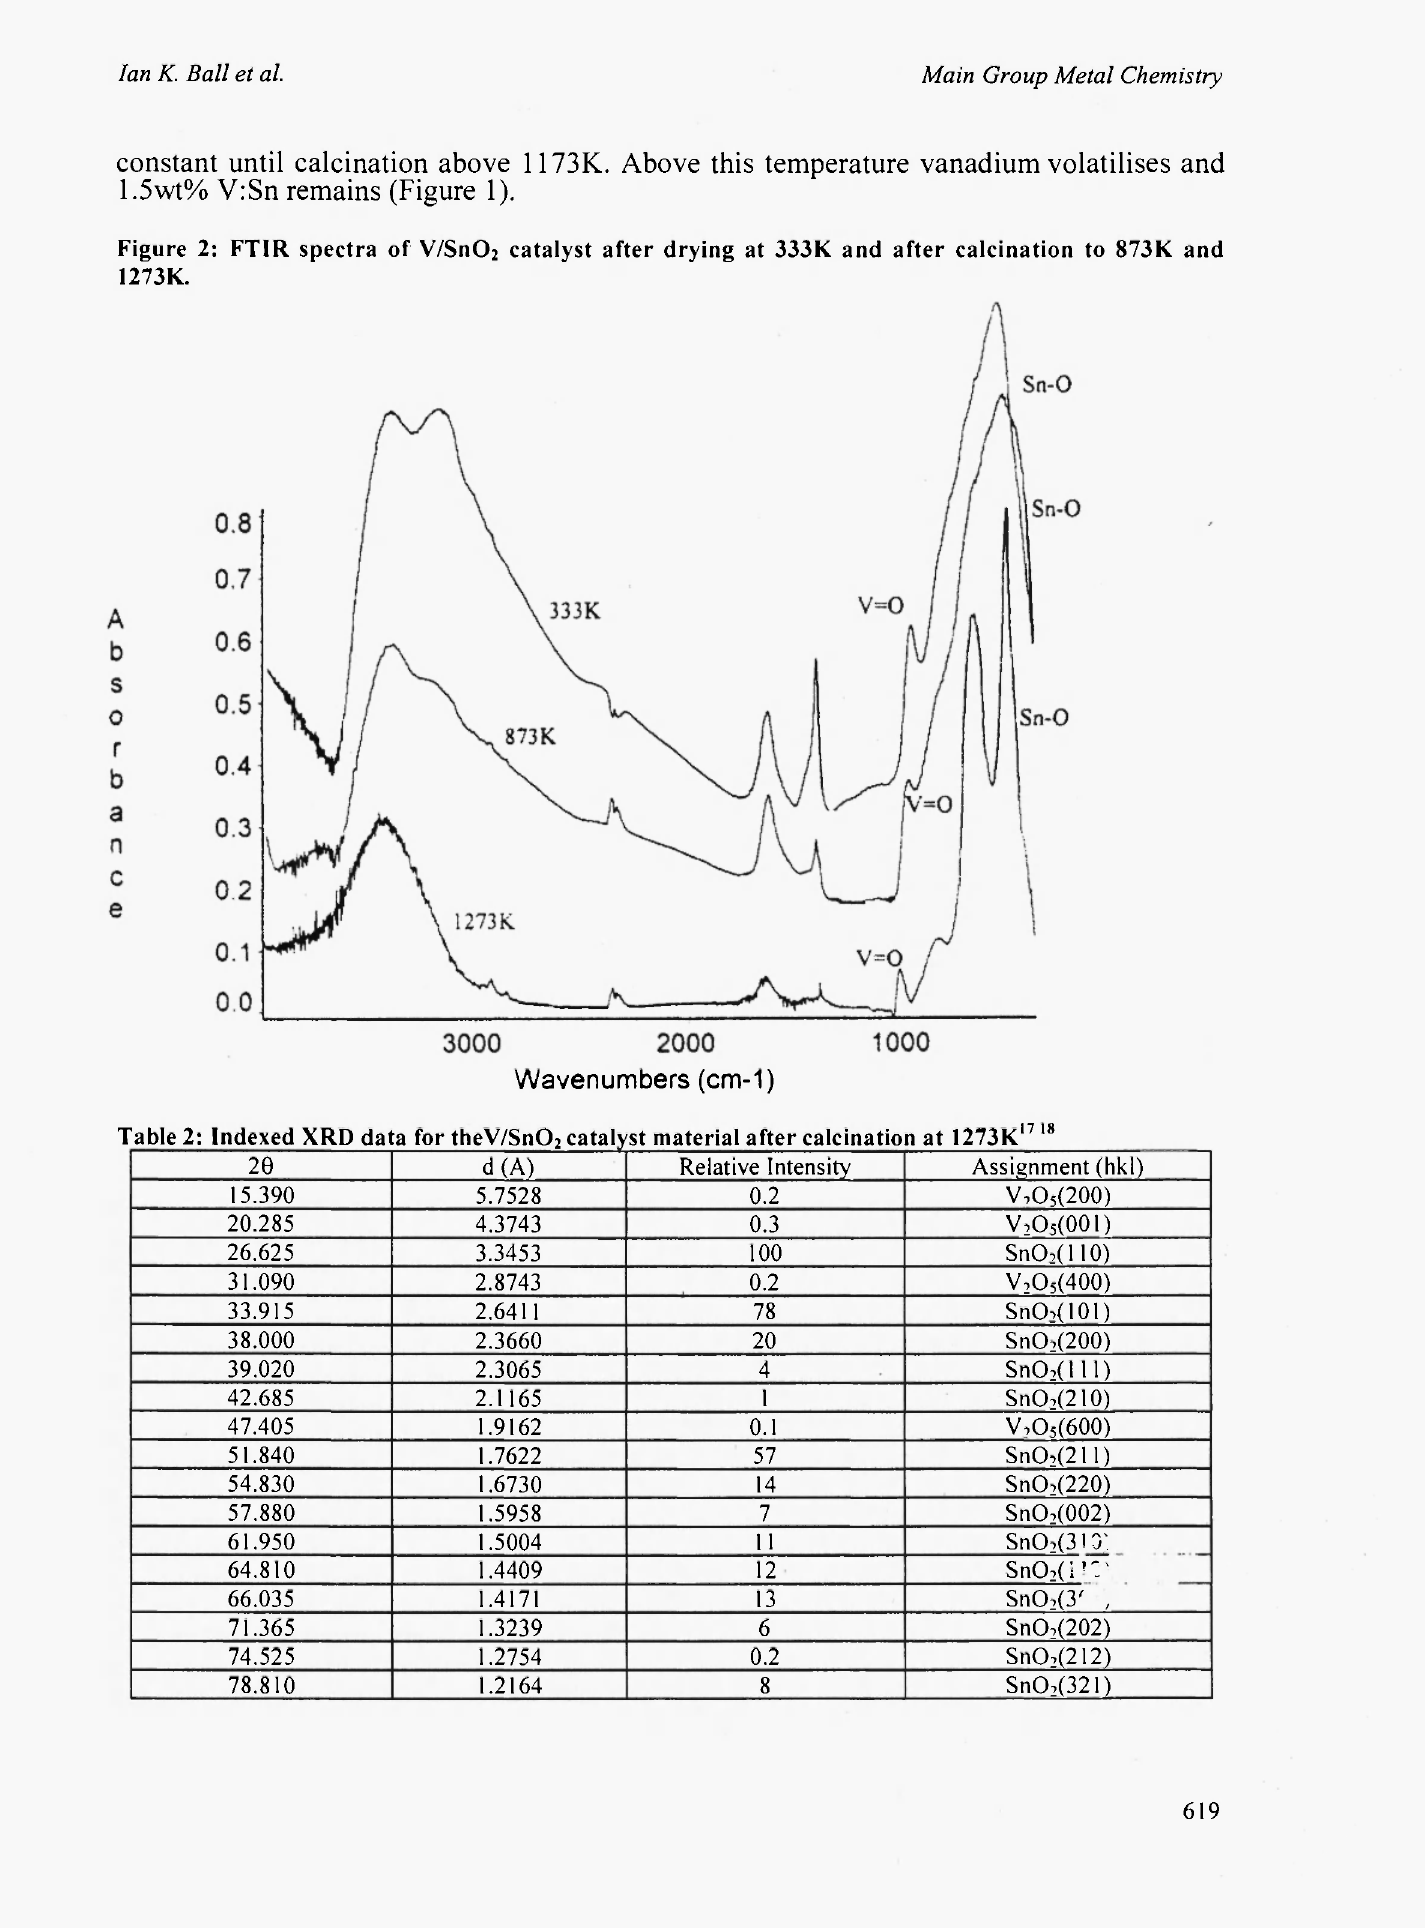
Table 2: Indexed XRD data for theV/Sn0 2 catalyst material after calcination at 1273K